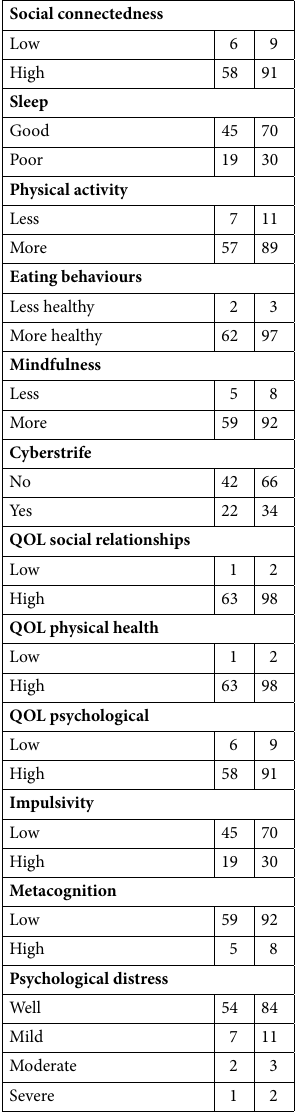
Table 2. LABS summary data used in BN for risk of psychological